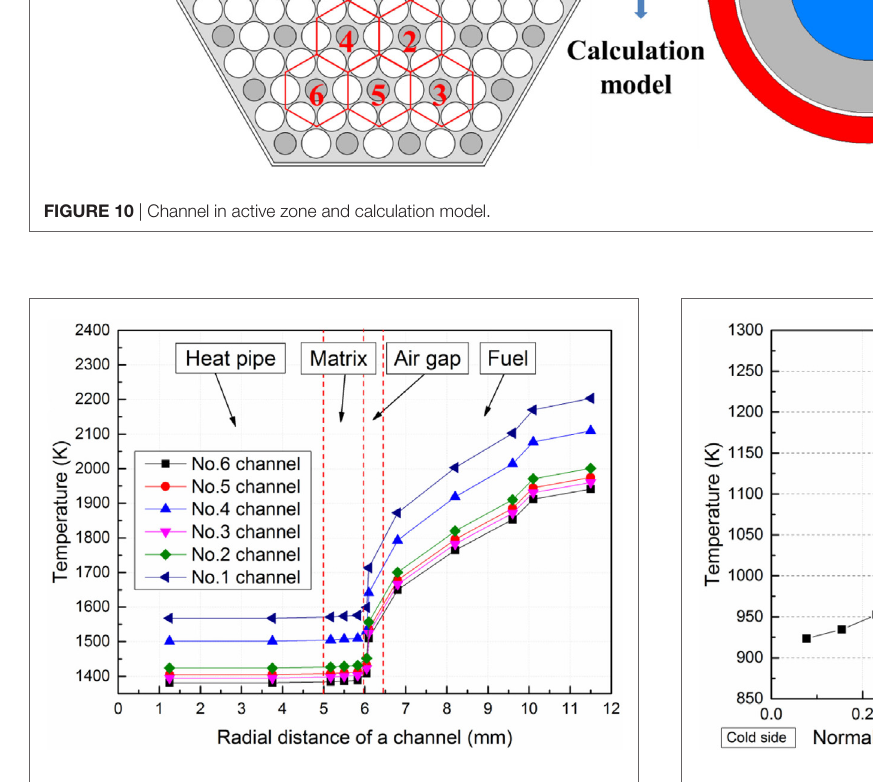
FigUre 11 | Temperature of active zone channels. FigUre 12 | Temperature of thermocouple